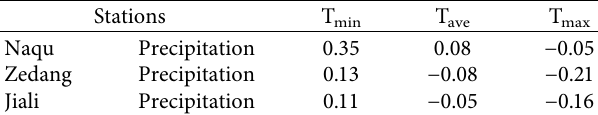
Table 5: Correlations between precipitation and air temperature of three